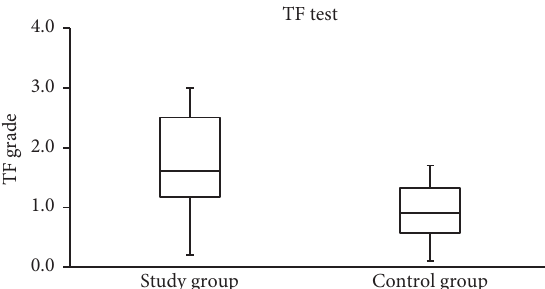
Figure 5: Side-by-side boxplots for the TF scores. A statistically significant difference was found at P < 0 . 001 (Mann–Whitney test). Table 2: Median (IQR) scores for the OSDI, PRT, and TF tests for subjects with mild ( N � 30) and moderate ( N � 20) RE. Parameter Mild RE ( N � 30) P value Moderate RE ( N � 20) P value OSDI 13.5 (21.5) 0.005 13.5 (13.5) < 0.001 PRT (mm) 26.5 (8.0) 0.002 29.0 (5.0) 0.089 TF 1.7 (1.3) < 0.001 1.5 (1.4)